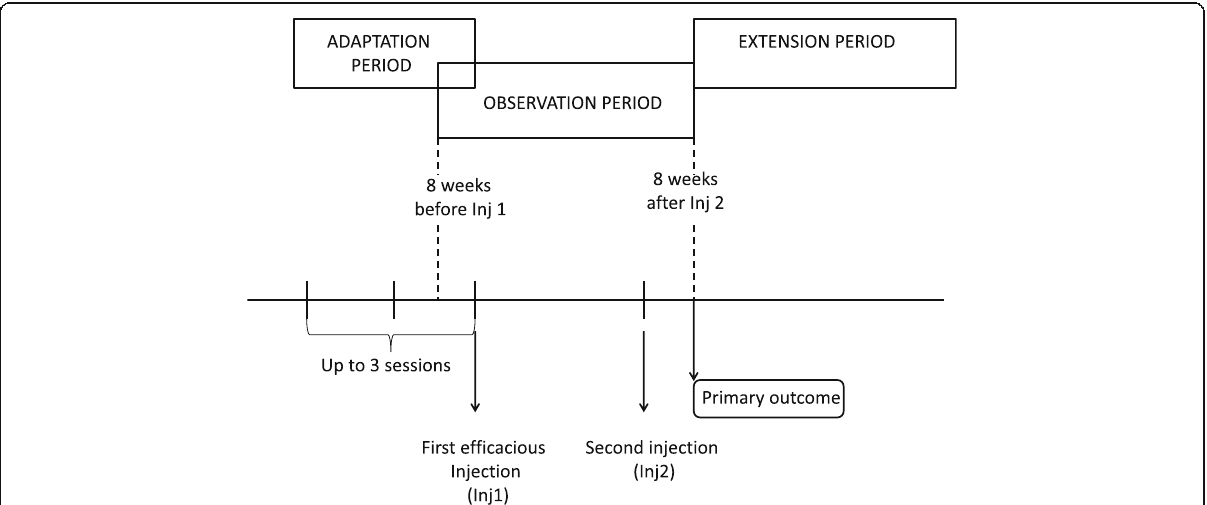
Fig. 1 Flow-chart. During a first phase, called adaptation period , we used a follow-the-pain approach in order to determine the optimal injection scheme for each individual. Once the best procedure was determined for each patient, it was reproduced at each subsequent injection session. This adaptation phase could necessitate up to three sessions. The observation period started 8 weeks before the first efficacious injection and ended 2 months after the second consecutive efficacious injection, or in case of inefficacy. Throughout the adaptation and the observation phases, patients kept a headache diary where they were asked to note the days with headache and the use of rescue medication. The extension period included all treatment cycles after the observation phase. During this period, the injector was allowed to modify